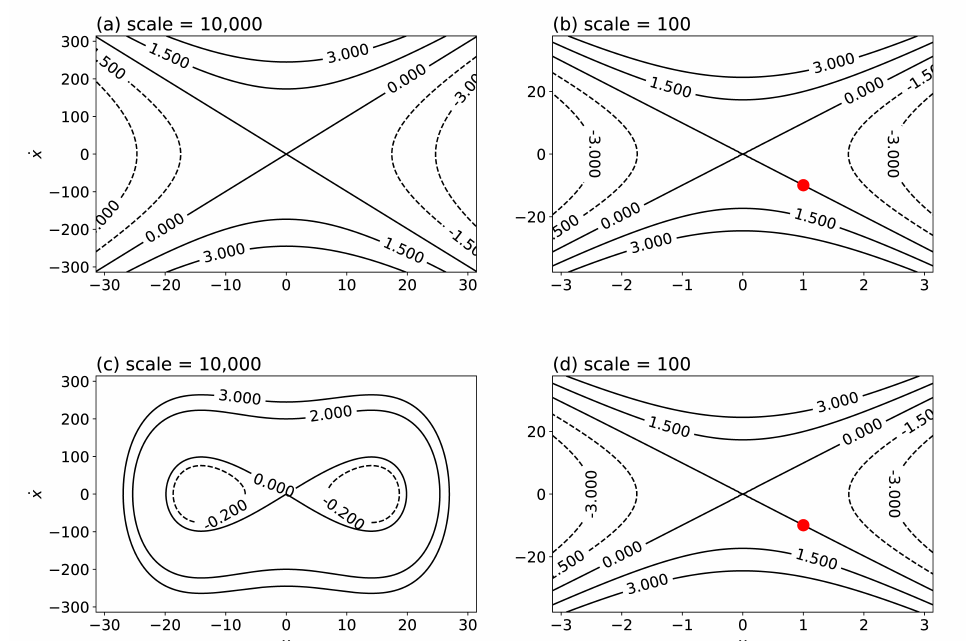
Figure 1: The contour lines of total energy in Eq. (2) for the linear (a, b) and nonlinear (c, d) systems of Figure 1. The contour lines of total energy in Equations (2a) and (2b) for the linear ( a , b ) and nonlinear X 10 π 2 X + X 3 / 2 = 0. Panels (b) and (d) provide a zoomed-in view of panels (a) and (c), respectively. A ( c , d ) systems of X (cid:48)(cid:48) 10 π 2 X + X 3 /2 = 0. Panels ( b , d ) provide a zoomed-in view of panels ( a , c ), ′′ − − large red dot at ( X, X ) = (1 , −√ 10 π ) displays a starting point of an orbit that moves along the zero contour line respectively. A large red dot at ( X , X (cid:48) ) = ( 1, −√ 10 π ) displays a starting point of an orbit that moves ′ along the zero contour line towards the origin. towards the origin.